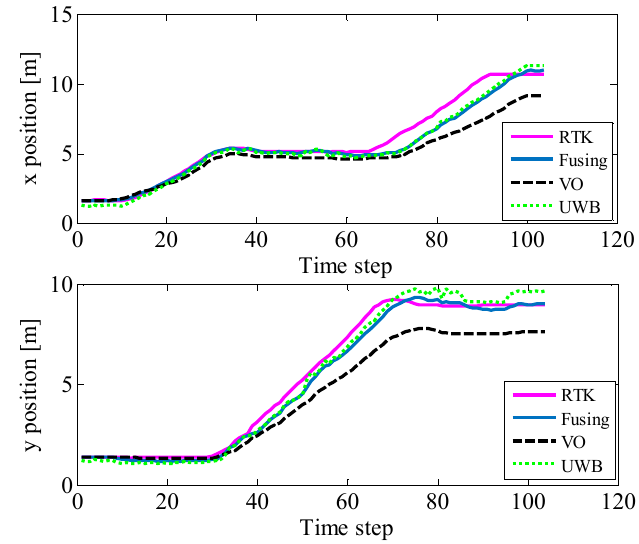
Figure 11. Position of different positioning methods in two directions.